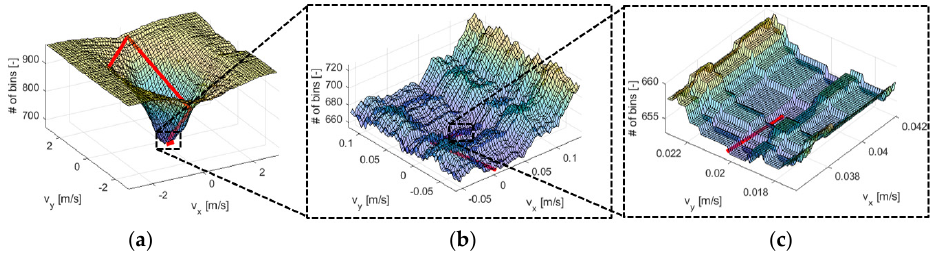
Figure 6. Illustration of the problem space for CV motion model at various scales: ( a ) large, ( b ) medium, and ( c )small scale.